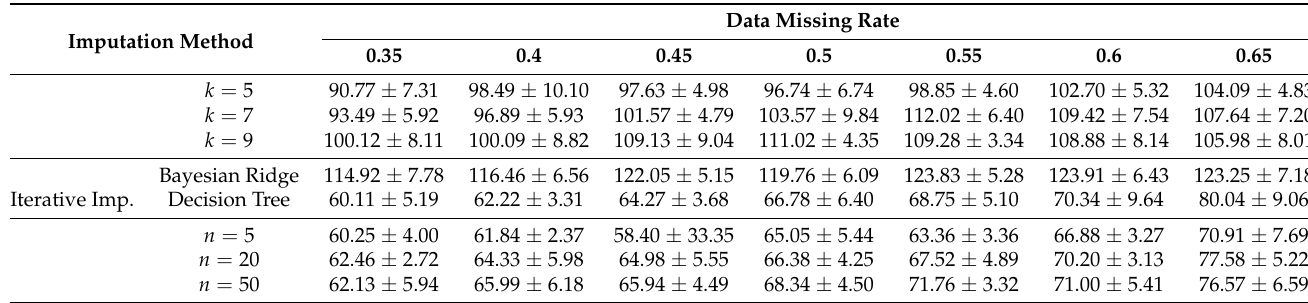
Table 3. The SMAPE score (mean and standard deviation) by using kNN imputation and iterative imputation.